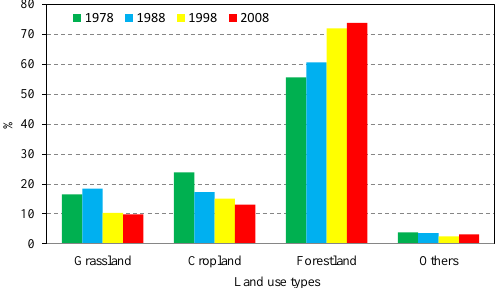
Figure 9. Land use composition of the Miyun Reservoir catchment (14653km 2 ) in 1978, 1988, 1998, and